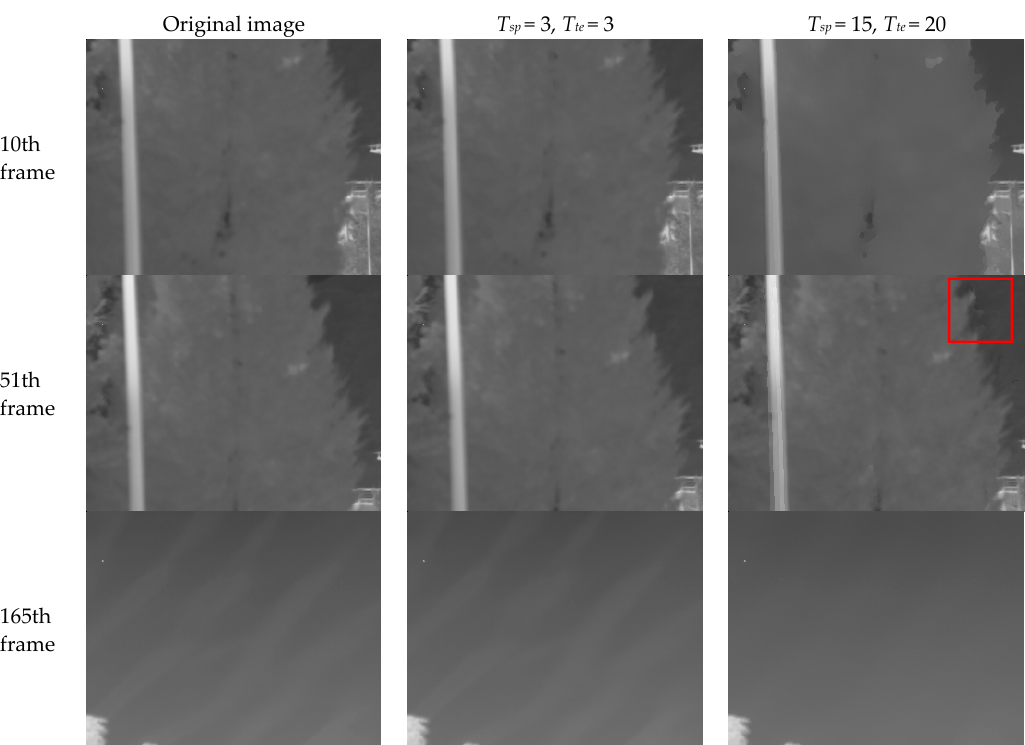
Figure 3. The temporal high-pass nonuniformity correction algorithm based on grayscale mapping (THP & GM) nonuniformity correction (NUC) performance with different threshold values. The red rectangular area shows the ghosting artifacts caused by the large threshold values.